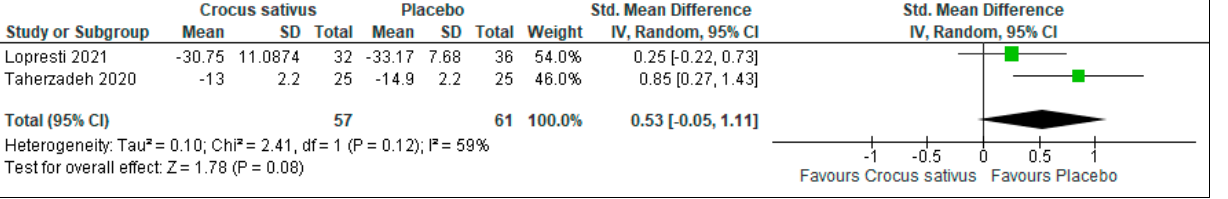
Figure 4. Forest plot for the outcome insomnia severity [25,29]. Note: Line indicates confidence interval and the green square indicates effect estimate. Black diamond indicates cumulative effect estimate and its confidence interval. Table 2. Summary of findings by GRADE assessment for the comparison between Crocus sativus and placebos in insomnia.